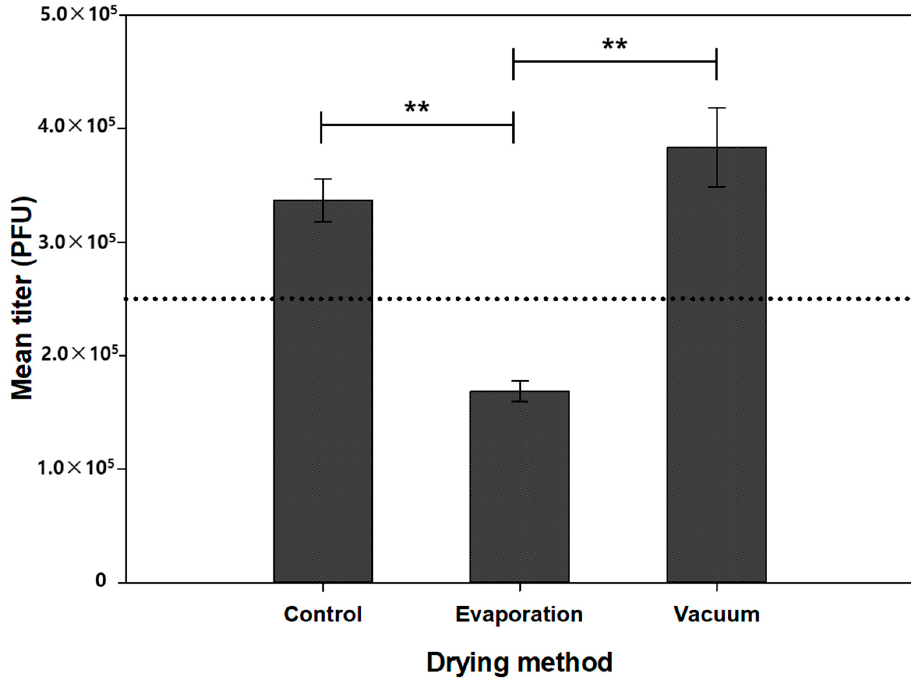
Figure 3. Effect of drying method on vaccine stability. Liquid formulation was used as a control. Statistical significance compared to the evaporation and vacuum drying samples was determined by a t -test (** p < 0.01).